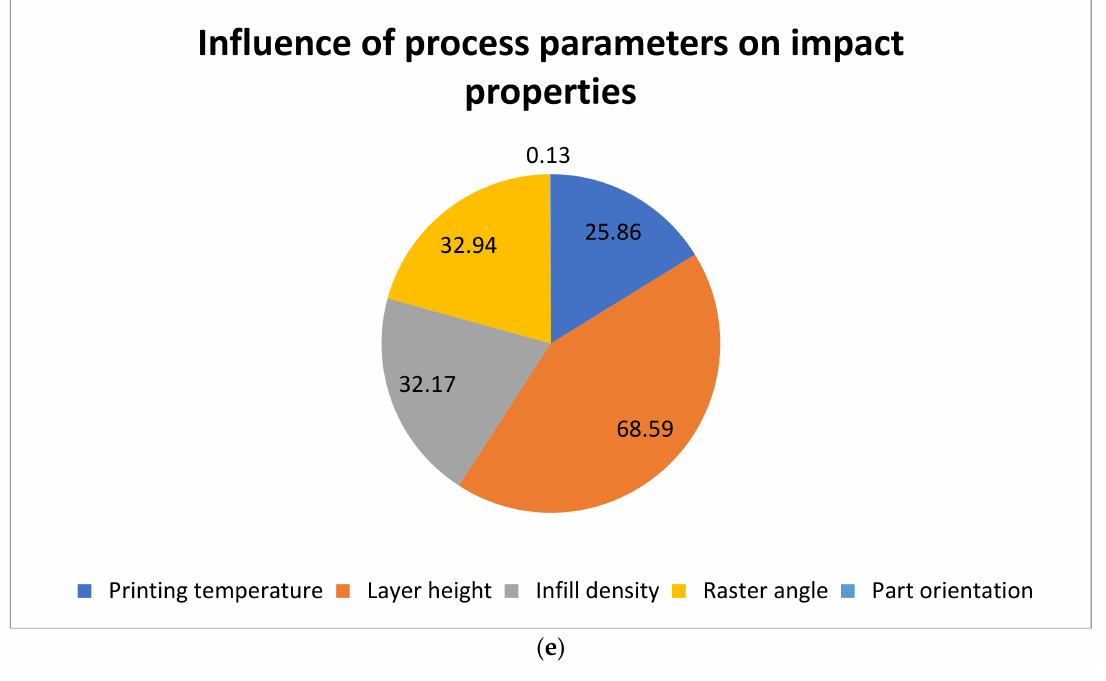
Figure 19. ( a ). Main effects plot for impact test responses. ( b ). Interaction plot for impact test responses. ( c ). Contour plot between layer height and infill density for maximum impact strength. ( d ). Contour plot between layer height and raster angle for maximum impact strength. ( e ). Contribu- tion plot of various factors for maximum impact strength.